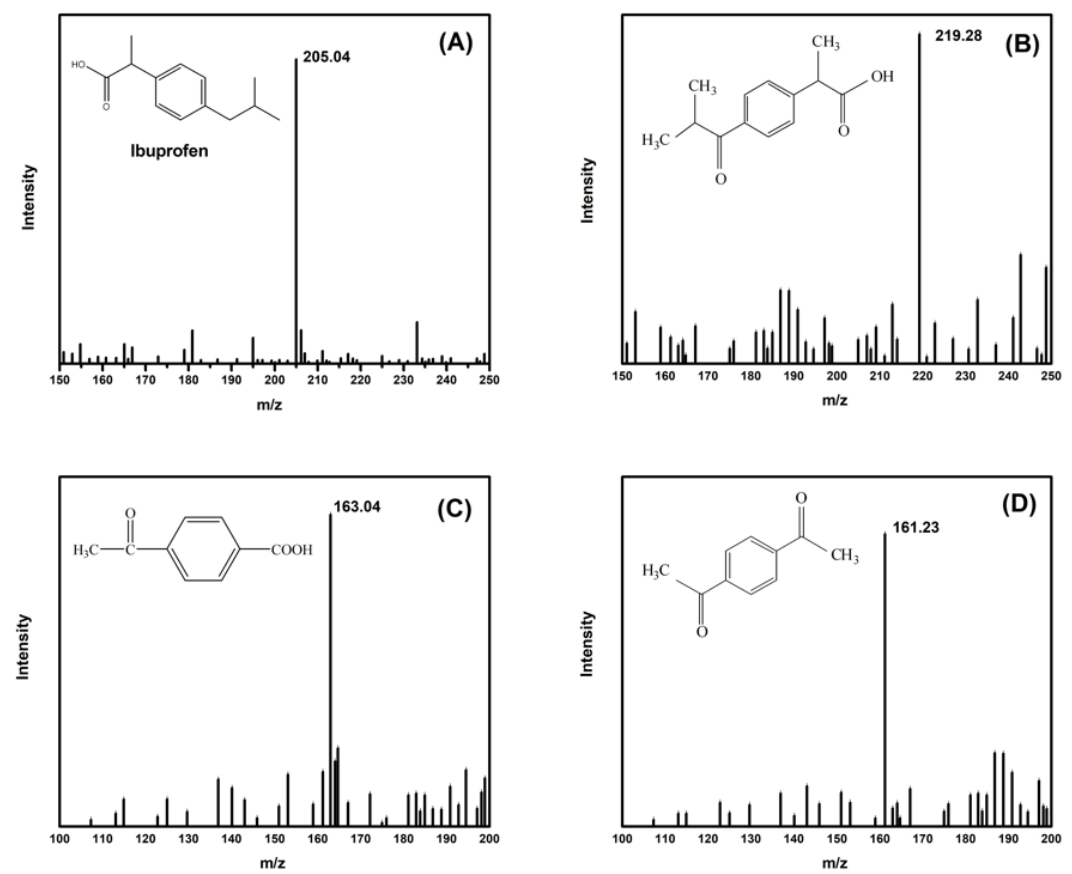
Figure 8. A possible intermediate of ibuprofen after ozonation. ( A ) ibuprofen; ( B ) 1,4-propanal phenylacetic acid; ( C ) 1,4-acetaldehyde benzoic acid; ( D ) p-phenylacetaldehyde.